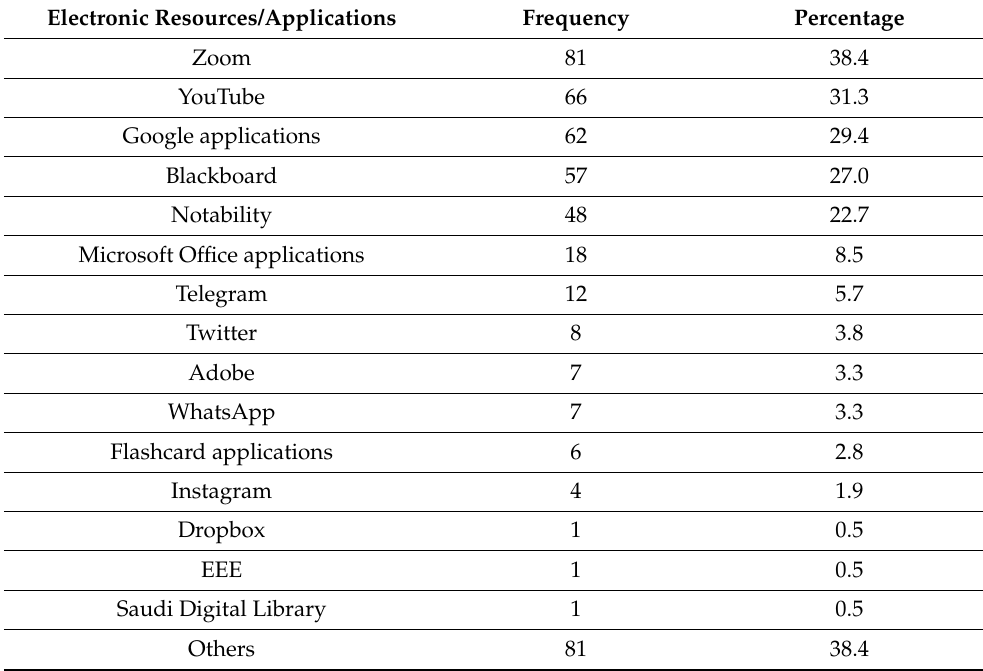
Table 2. Frequency distribution of students’ most frequently used electronic resources/applications in decreasing